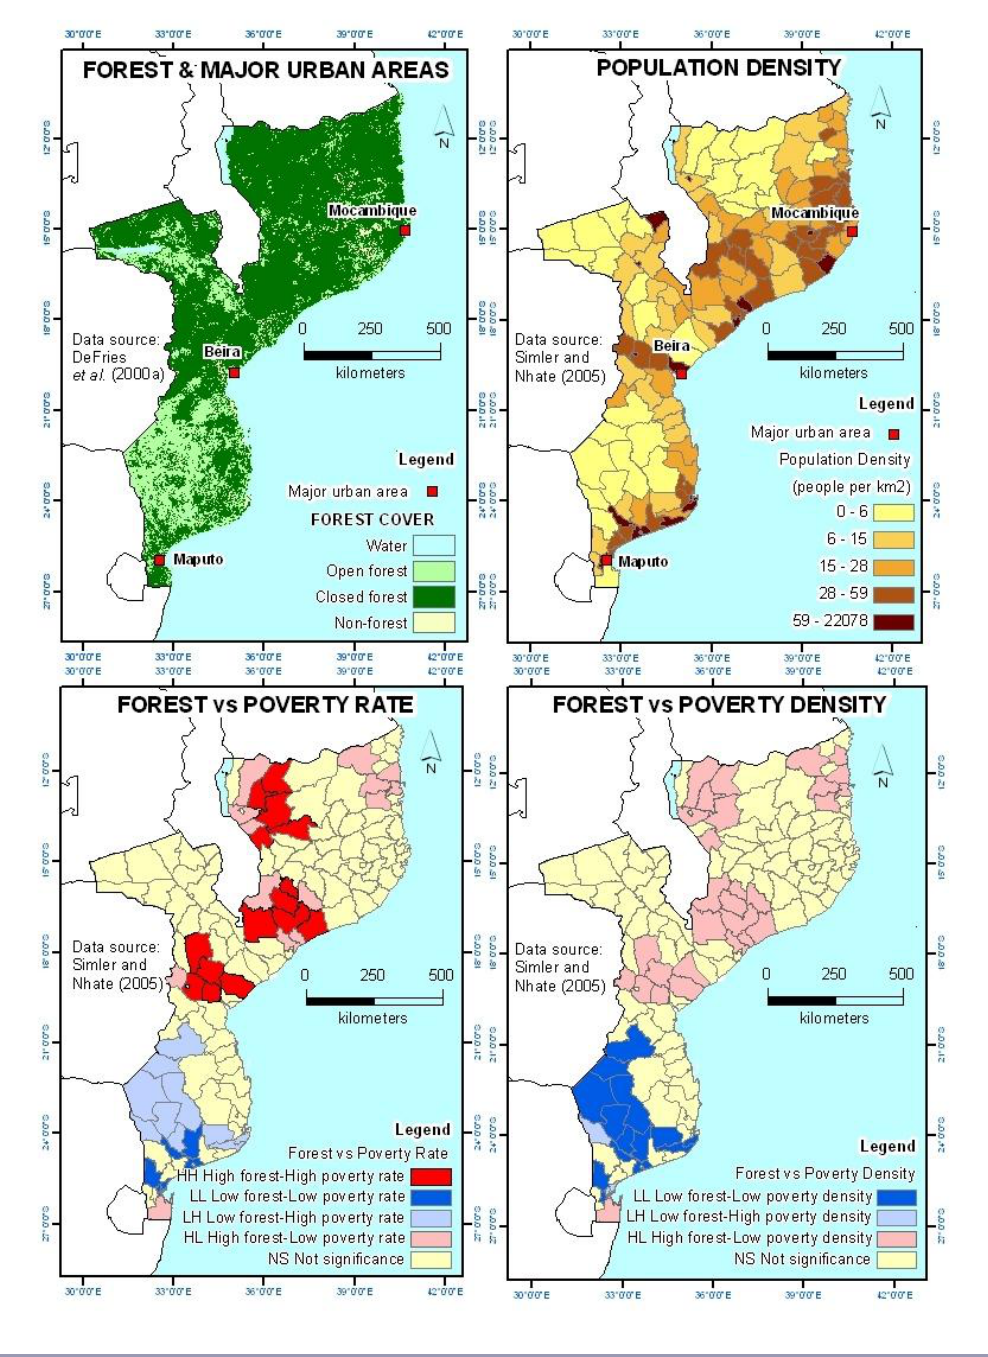
Fig. 4. . Mozambique. Maps of forest and major urban areas, population density, local indicators of spatial association (LISA) analysis of forest cover by poverty rate, and LISA analysis of forest cover by poverty